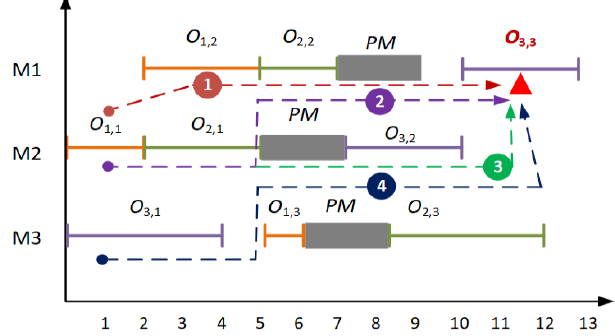
Figure 2. A feasible schedule that has executed PM